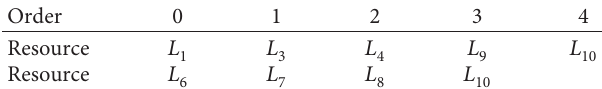
Table 3: The order of